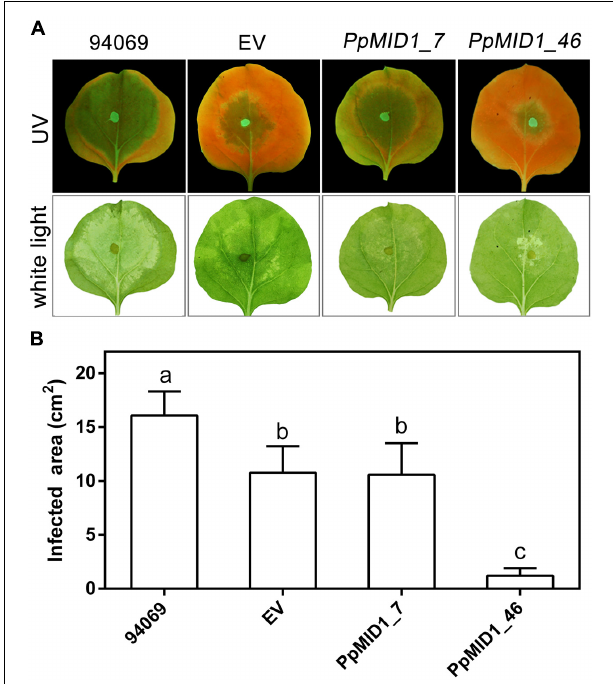
FIGURE 9 | PpMID1- silenced transformants show reduced virulence on plants. (A) Disease symptoms on Nicotiana benthamiana leaves caused by Phytophthora parasitica infection. For inoculation, mycelia disks (5 mm id.) of PpMID1_7 and PpMID1_46 , EV, or wild-type P. parasitica (94069) were transferred to the center of leaves from 5-week-old N. benthamiana . After incubation in a moisture box at 25 ◦ C for 72 h, disease symptoms were examined and photographed under ultraviolet light (UV) or white light. (B) Quantification of infected areas on the inoculated N. benthamiana leaves. Infected areas on the inoculated leaves shown in (A) under UV light were measured by using ImageJ. Data are mean ± SD from 4 independent experiments (each with six leaves). Different letters indicate significant difference by Fisher’s least significant difference test ( P <